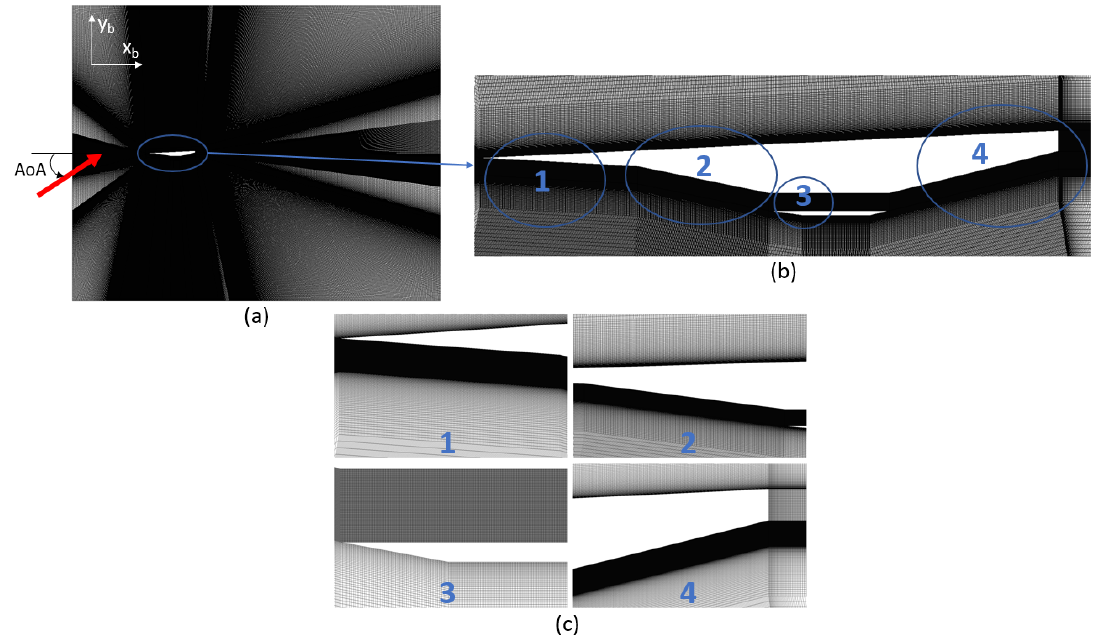
Figure 2. Grid used in the present study, ( a ) entire mesh domain, ( b ) mesh nearby the body, ( c ) mesh details at several body